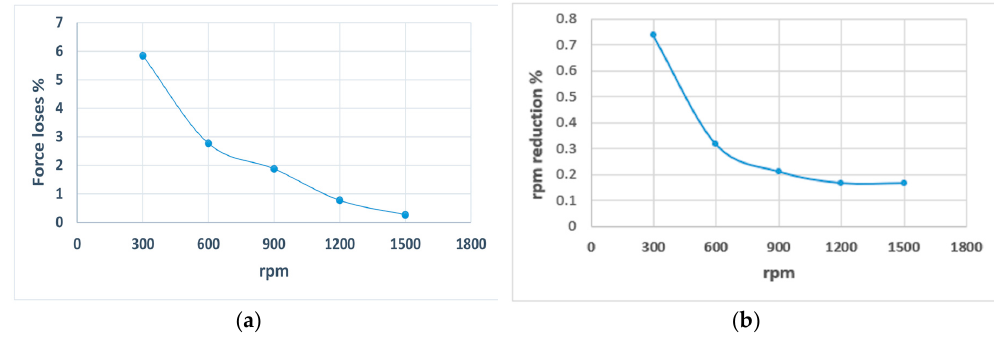
Figure 19. ( a ) Force loses percentage and ( b ) rpm reduction percentage.